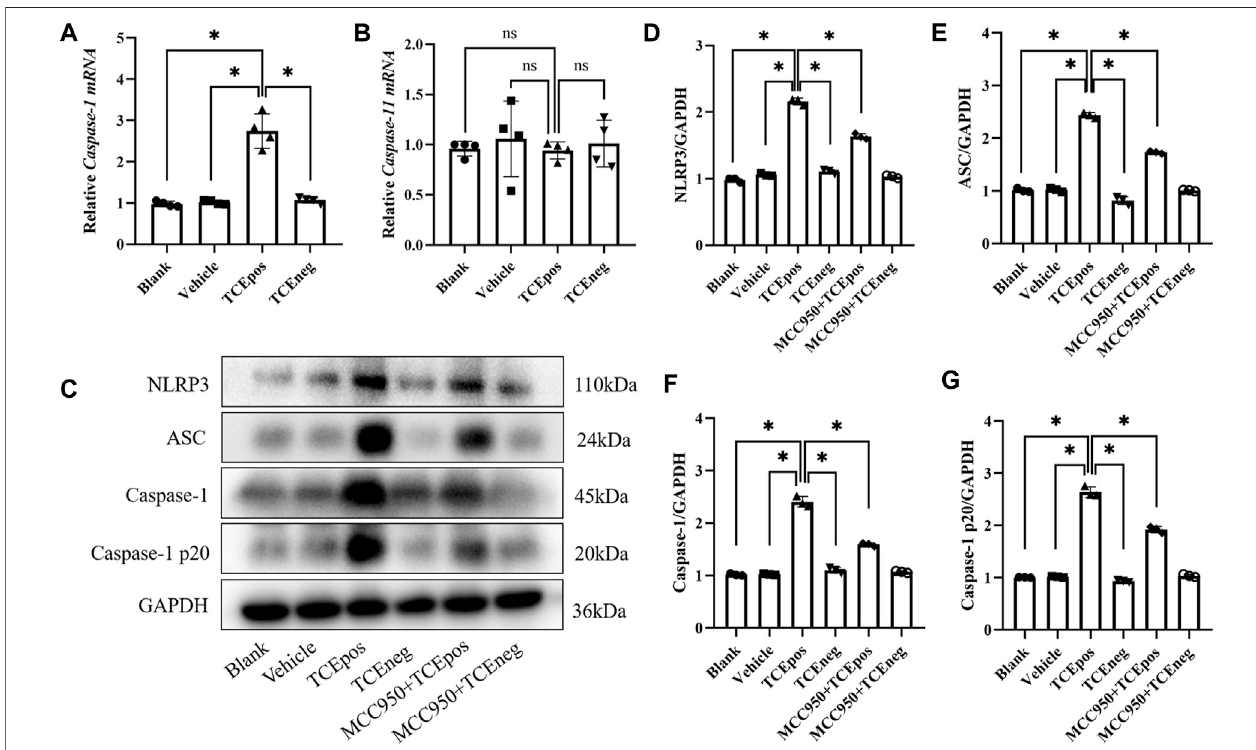
FIGURE4| Caspase-1 – dependent canonical pathway activated RTEC pyroptosis. (A,B) Genelevels of caspase-1 mRNA (A) and caspase-11 mRNA (B) in mice. (C) Representative immunoblot for expression of NLRP3, ASC, caspase-1, caspase-1 p20, and GAPDH. (D – G) Relative expression of the abovementioned proteins wasassessedbytheaverageopticaldensityvalueinImageJ.AlltheWesternblottestsforNLRP3,ASC,caspase-1,andcaspase-1p20wererepeatedthreetimes,and the data are expressed as the mean ± SD. n = 3 – 5/group. Levels of signi fi cance were de fi ned as below: * p <